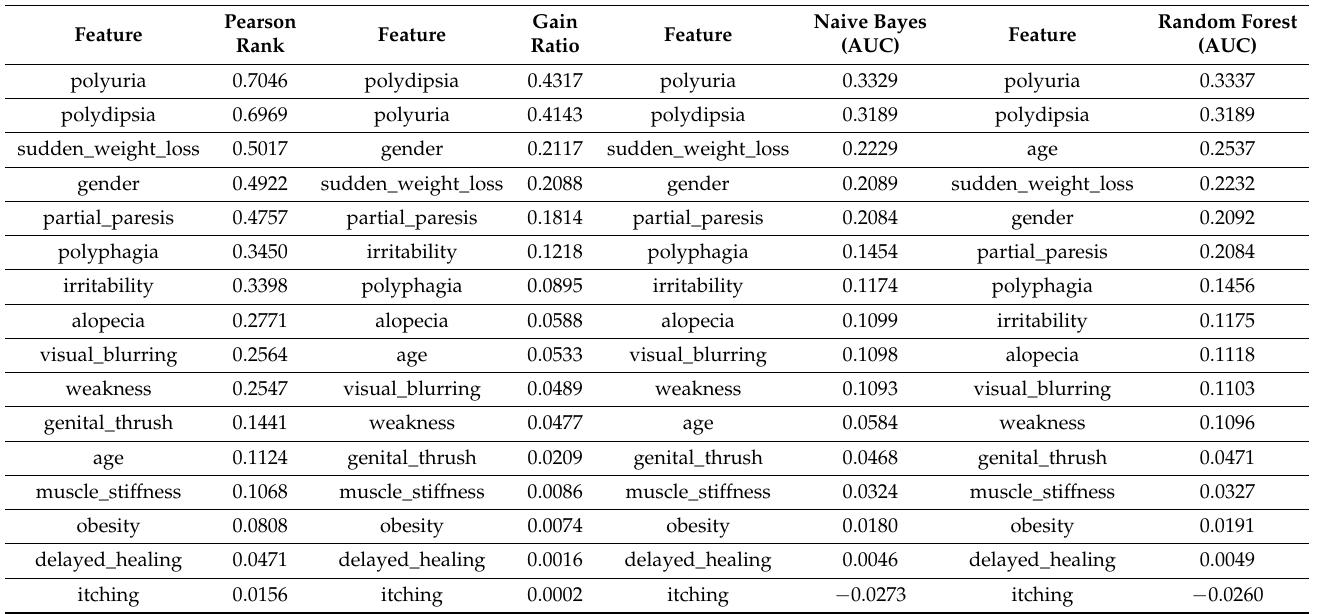
Table 2. Evaluation of feature importance based on the Pearson Correlation, Gain Ratio, Naive Bayes and Random